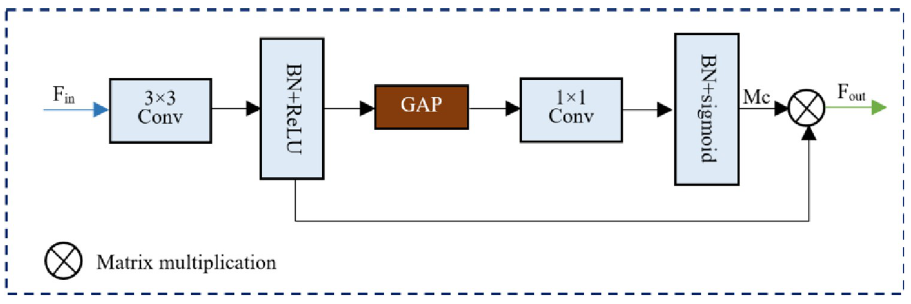
Fig 3. The channel attention optimization module